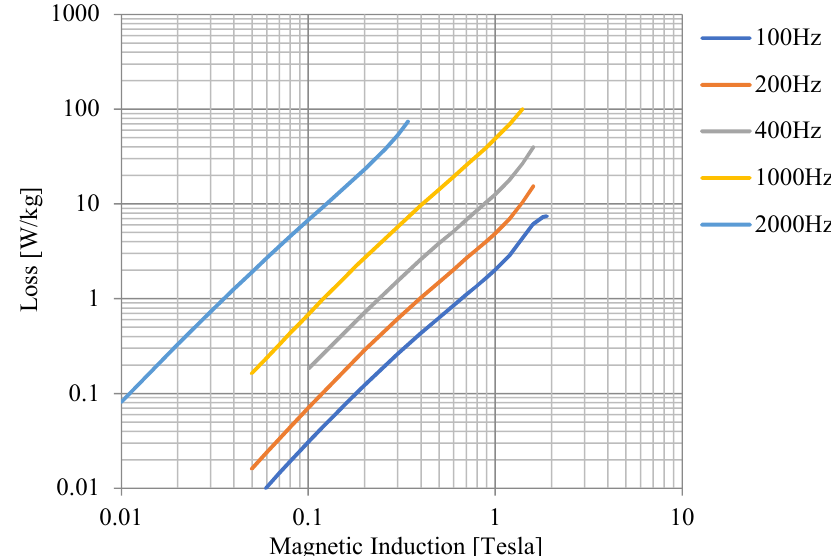
Figure 16. The relationship between core loss and frequency of 20PNF1500. Even when the permanent magnet rotor of a permanent magnet synchronous motor rotates freely, it will cause core loss in the stator core. The change in core loss with speed is shown in Figure 17, and the value of loss is listed in Table 5.